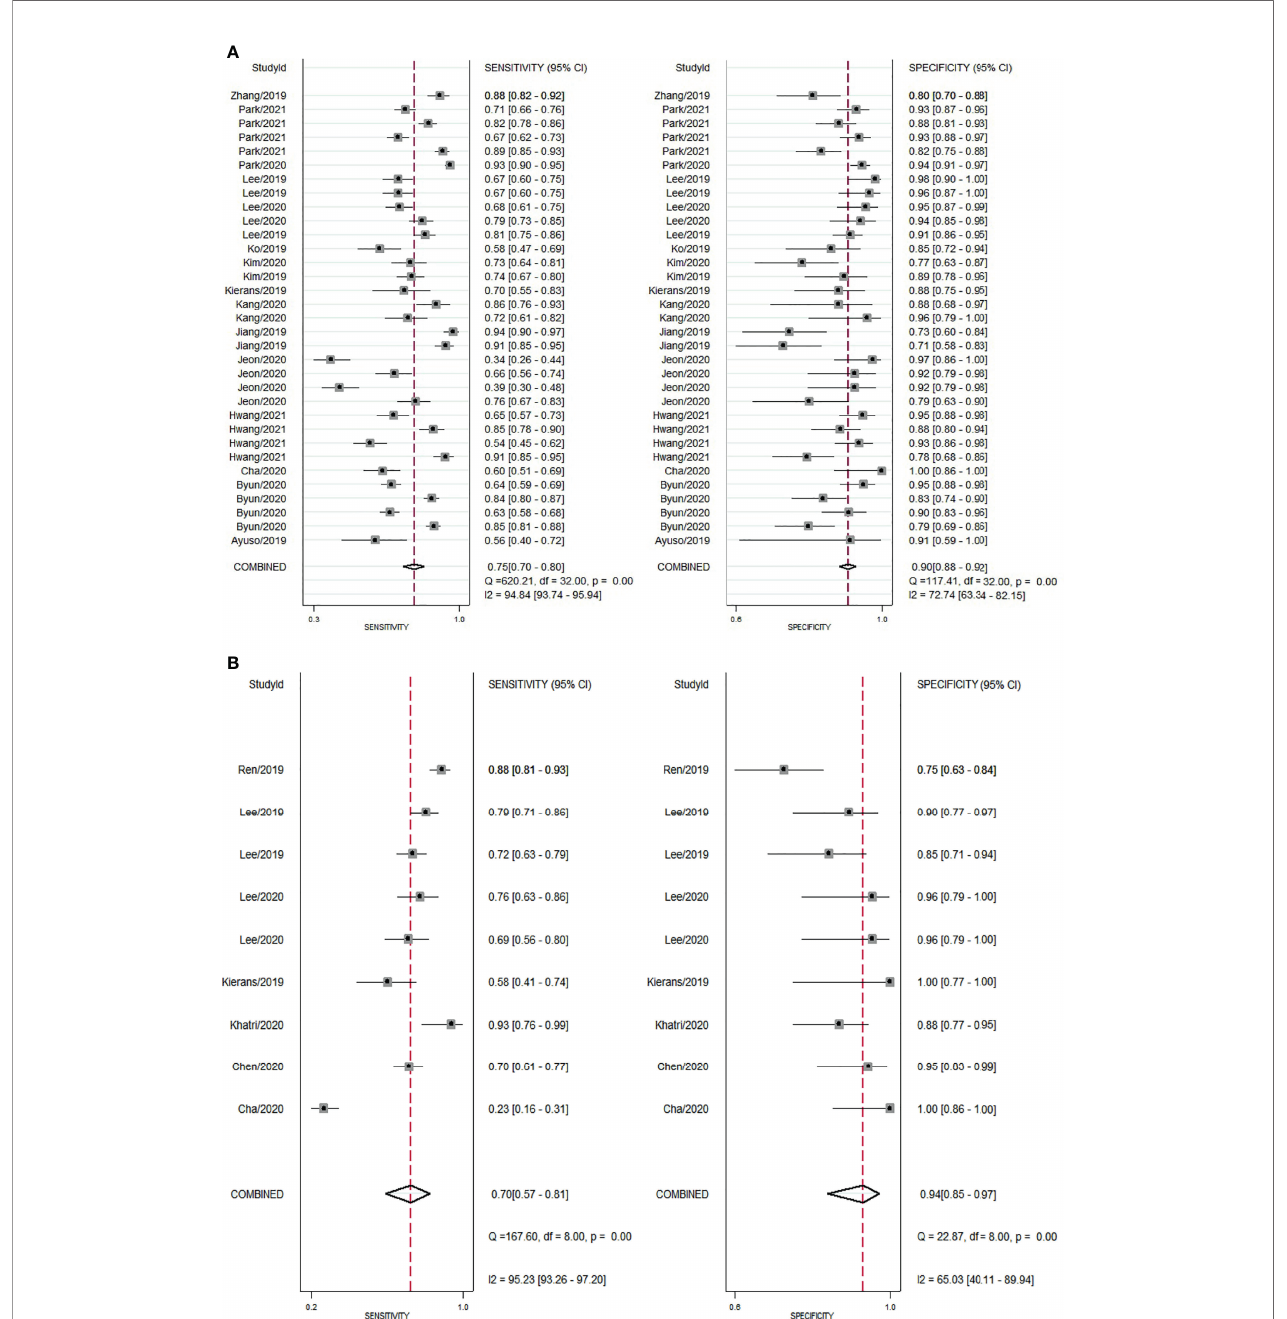
FIGURE 3 | Forest plot showing pooled sensitivity and speci fi city for contrast-enhanced MRI. (A) gadoxetic acid-enhanced MRI. (B) ECA-MRI. ECA, extracellular contrast